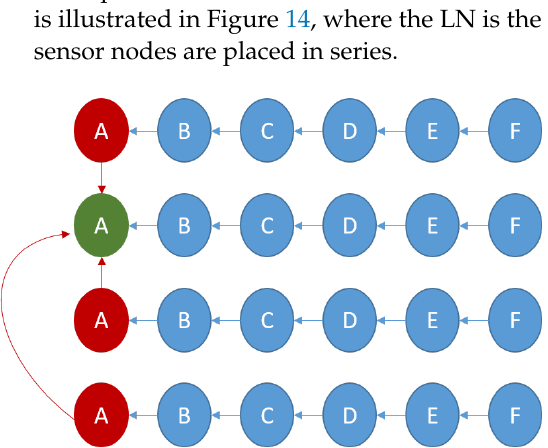
Figure 14. MD-Chain-MH